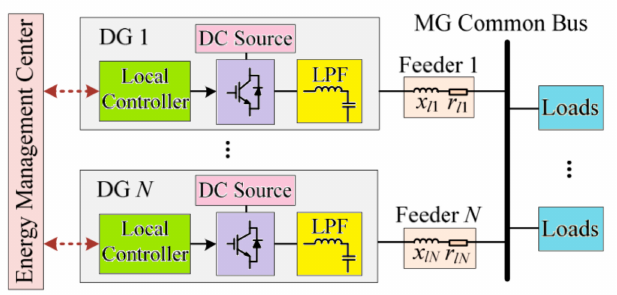
Figure 2. Block diagram of a typical MG consisting of several distributed generations (DGs).